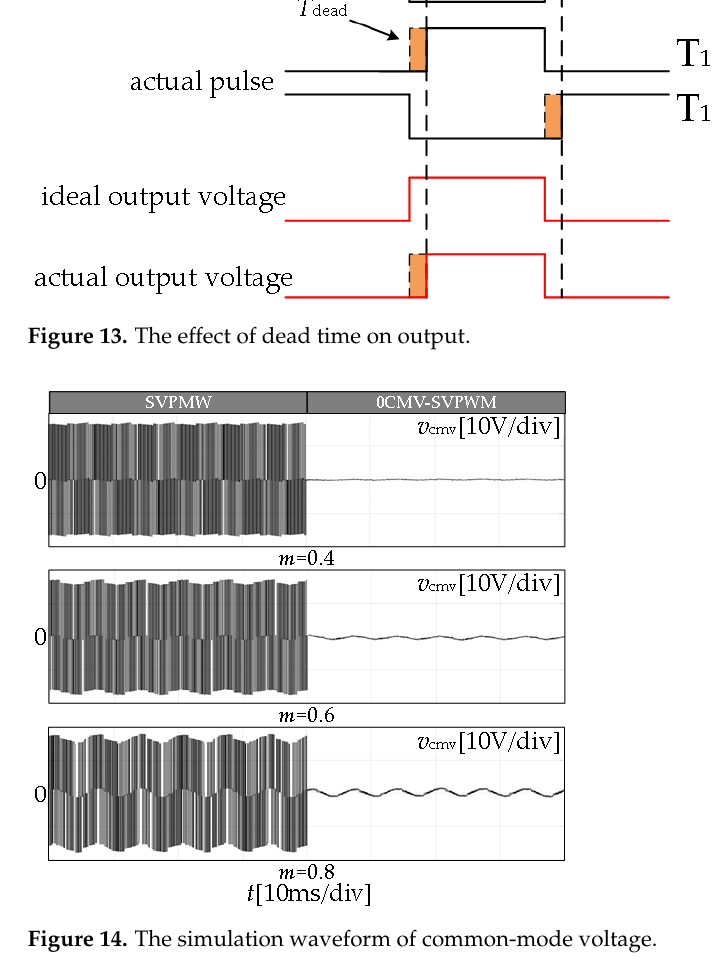
Figure 14. The simulation waveform of common-mode